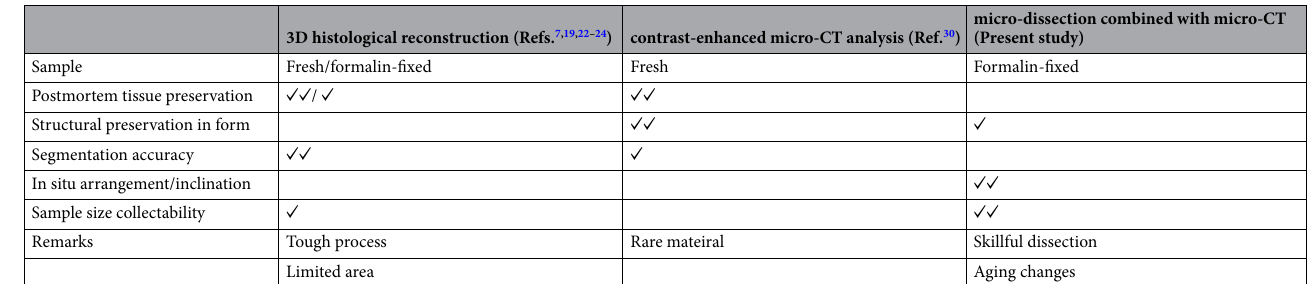
Table 3. General characteristics in human CCS structural